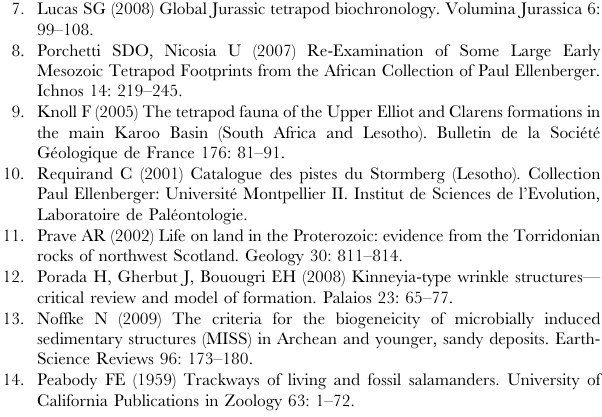
Table S1 Measurements of Episcopopus trackway at Moyeni, Lesotho. Numbers identifying the successive manus ( m ) and pes ( p ) in the trackway follow original Ellenberger’ [3] numbering. Linear measurements are expressed in centimeters and angles in degrees; em-dash denotes missing datum due to preservation